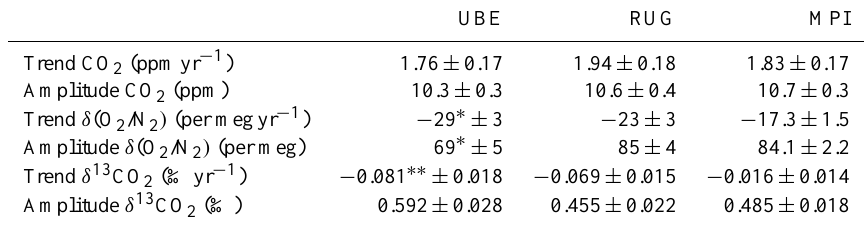
Table 3. CO 2 , δ (O 2 /N 2 ) and δ 13 CO 2 trends and seasonal amplitudes based on the fit of the data sets from each laboratory: UBE, RUG and MPI. The used fit is a linear combination of a linear trend plus a double (for CO 2 ) or single (for δ (O 2 /N 2 ) and δ 13 CO 2 ) harmonic seasonal component. The stated errors are the uncertainties of the fit